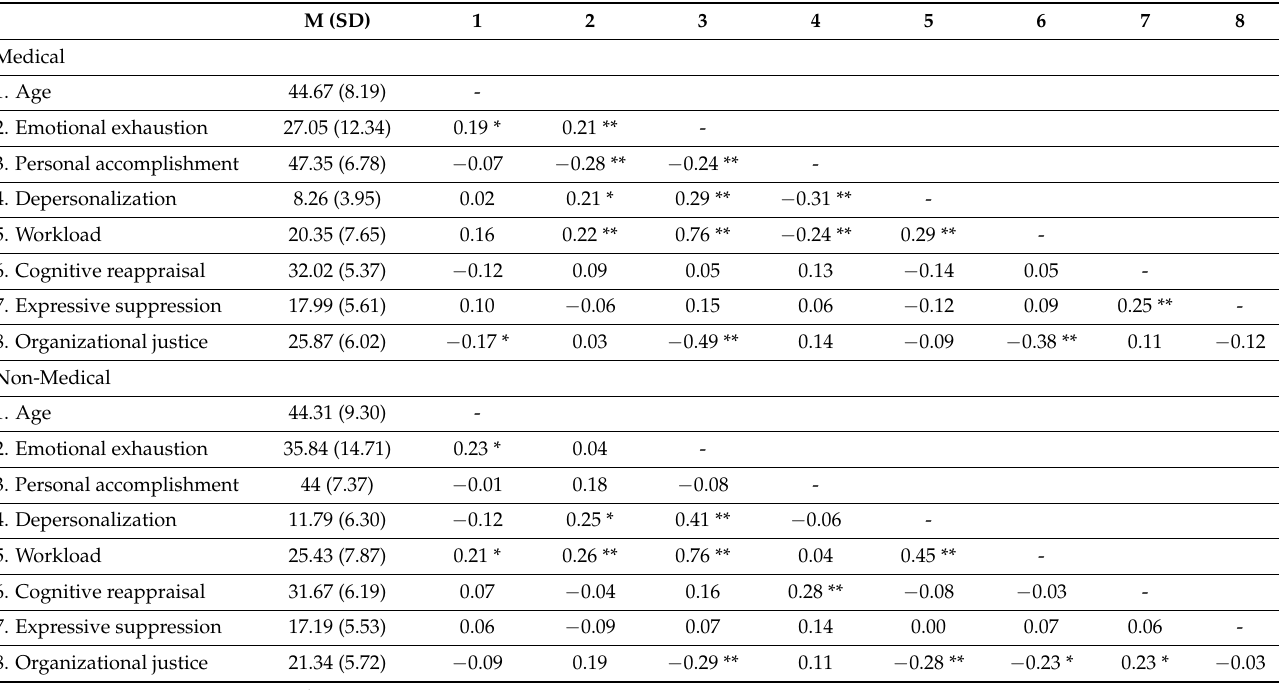
Table 2. Descriptive statistics and Pearson correlations 1